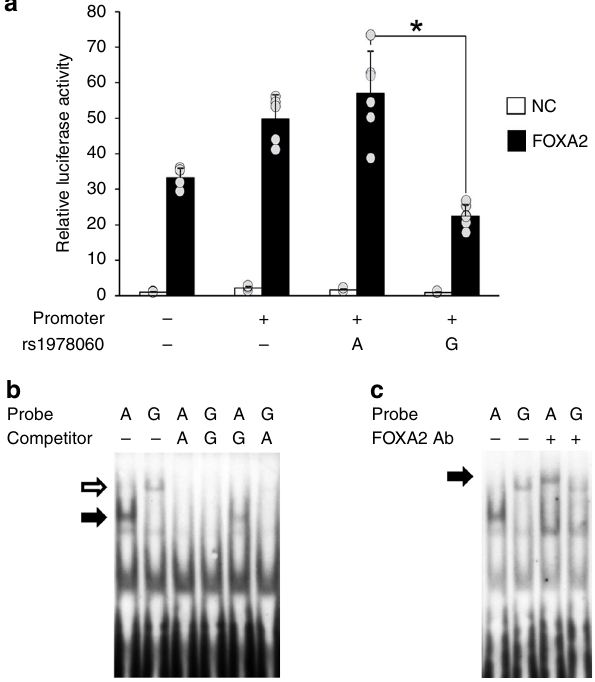
Fig. 3 Allelic difference of functional variant, rs1978060 in Chr.22q11.21. a Reporter assays in MCF-7 cells. There was a signi fi cantly decreased transcriptional activity for the risk G-allele of rs1978060 compared to the non-risk A-allele. Error bars show standard deviation (S.D.) for each variant. Asterisks indicate statistically signi fi cant changes in paired comparison ( t -test P < 0.01). n = 2 independent experiments. b Electrophoretic mobility shift assays with nuclear extracts from MCF-7 cells. There was speci fi c bands for A-allele probe (lane 1, black arrow) and the G-allele probe (lane 2, white arrow) of rs1978060. Competition analyses were performed using an excess of the unlabeled A-allele probe (lane 3, lane 6) and G-allele probe (lane 4, lane 5) as competitors. c A super-shift assay using the FOXA2 antibody. The black arrow indicates a super-shifted FOXA2 complex in lane 3. Source data are provided as a Source Data fi